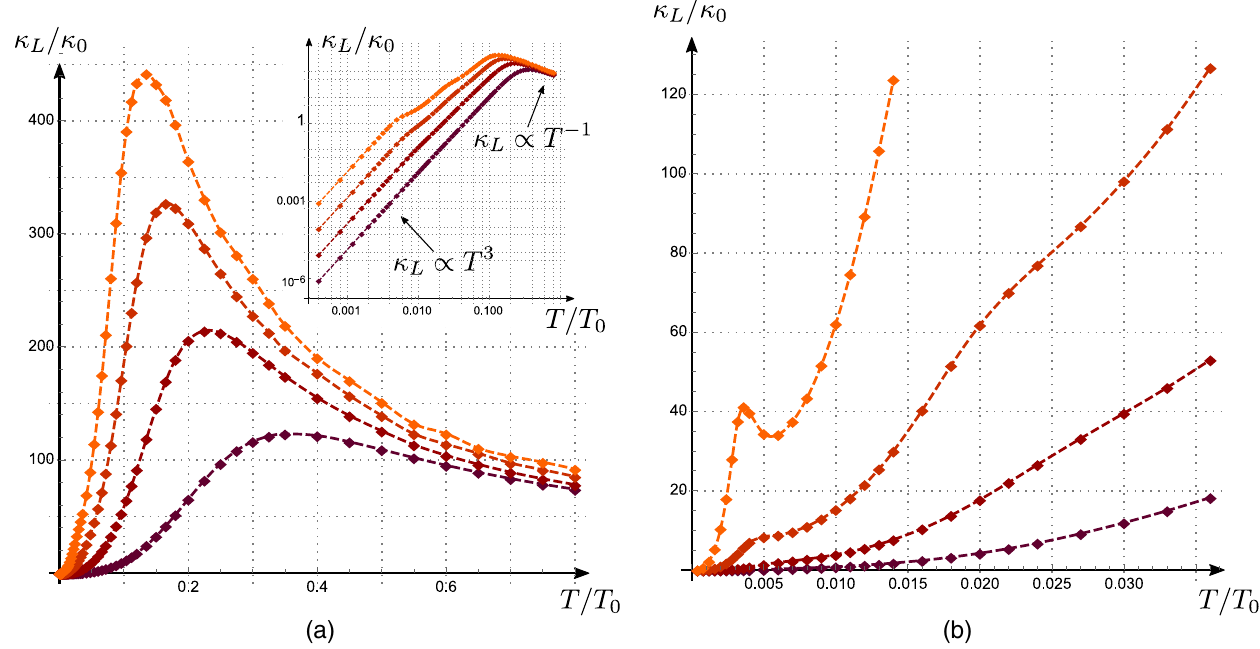
FIG. 3. Longitudinal thermal conductivity κ with respect to temperature T , for four different values of γ . (a) Results on an order- L ext 1 × 10 − z ð v = a Þ ; z ∈ ⟦ 4 ; 7 ⟧ , from darker ( z ¼ 4 ) to lighter ( z ¼ 7 ) shade. A crossover occurs one temperature scale, with γ ext ¼ ph between two scaling regimes with x ¼ 1 and x ¼ − 1 [see Eq. (23)]. Inset: log-log plot. The scaling behaviors are consistent with the 1 × 10 − z ð v = a Þ ; z ∈ ⟦ 6 ; 9 ⟧ , from darker ( z ¼ 6 ) to analysis presented in the text. (b) Results on a smaller temperature scale, with γ ext ¼ ph lighter ( z ¼ 9 ) shade. The peaks are features related to the magnon gaps.